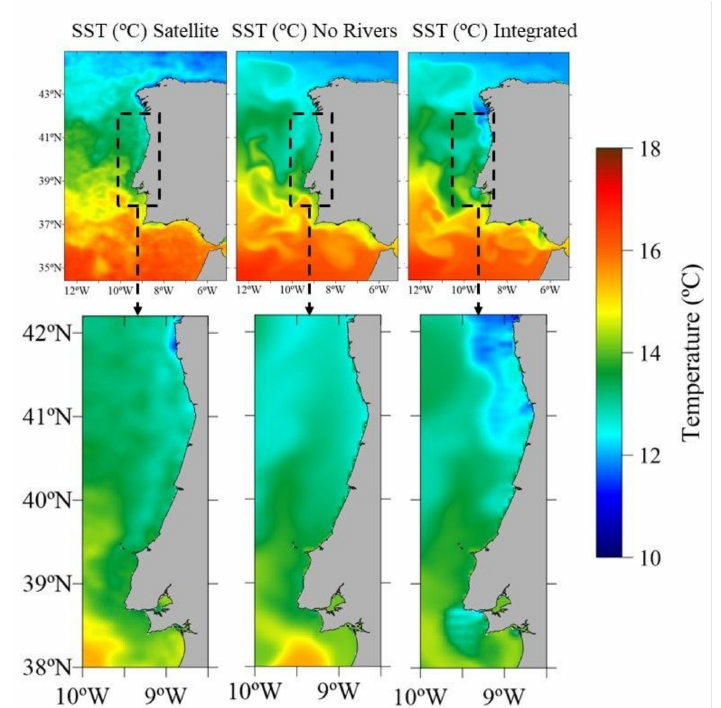
Figure 8. Average surface temperature maps for the entire domain (top) and a zoom over the area of interest on the west coast of the IP ( bottom ) produced by the two implementations: Satellite SST ( left ), no-rivers ( middle ) and integrated ( right ) methodologies and at the peak flow (20 March 2018).